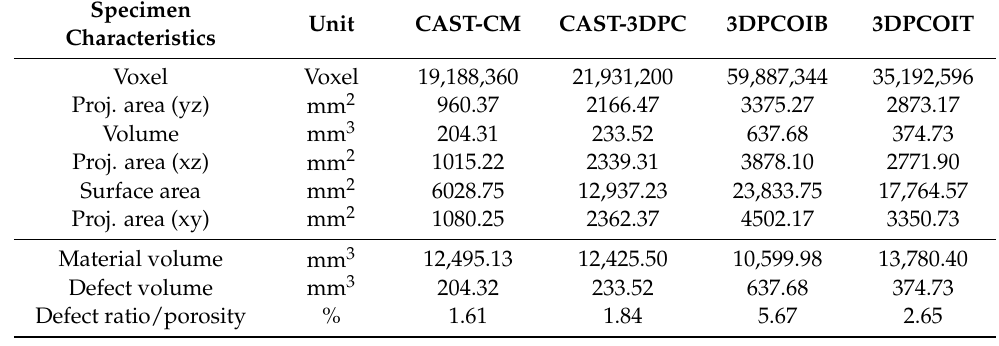
Table 5. Porosity characteristics of all specimen groups obtained from µ -CT scanning. Specimen Characteristics